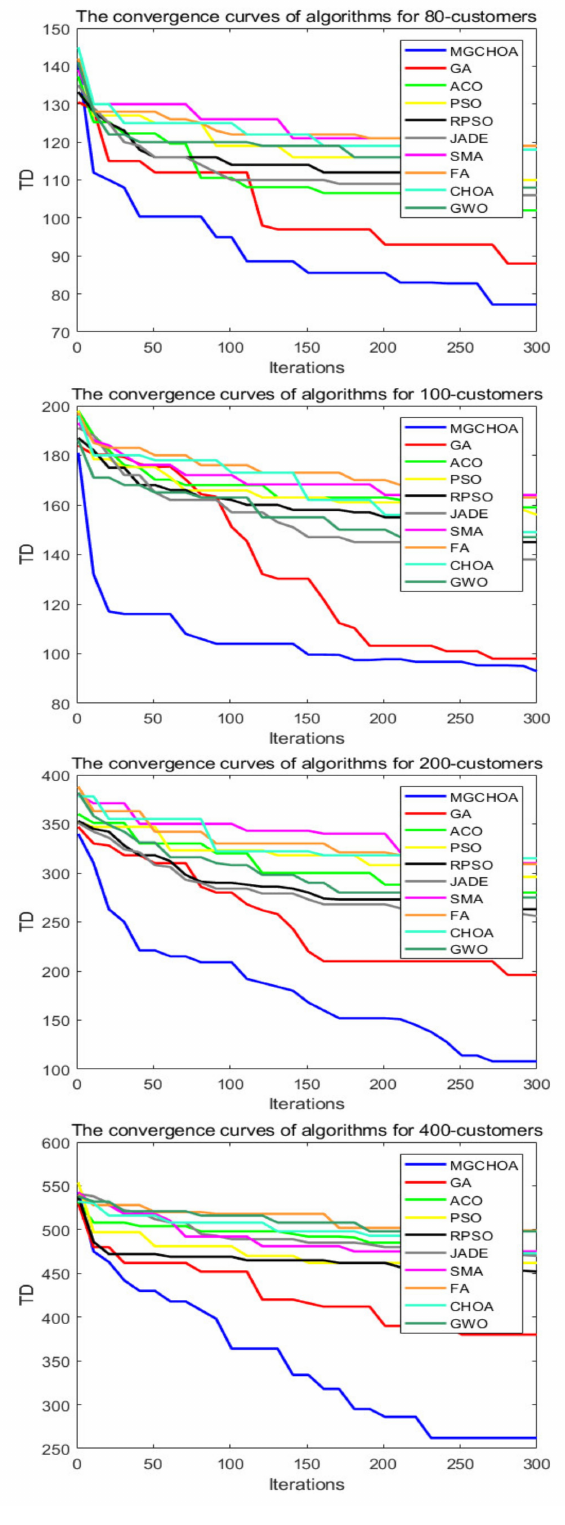
Figure 10. The convergence curves after 300 iterations of